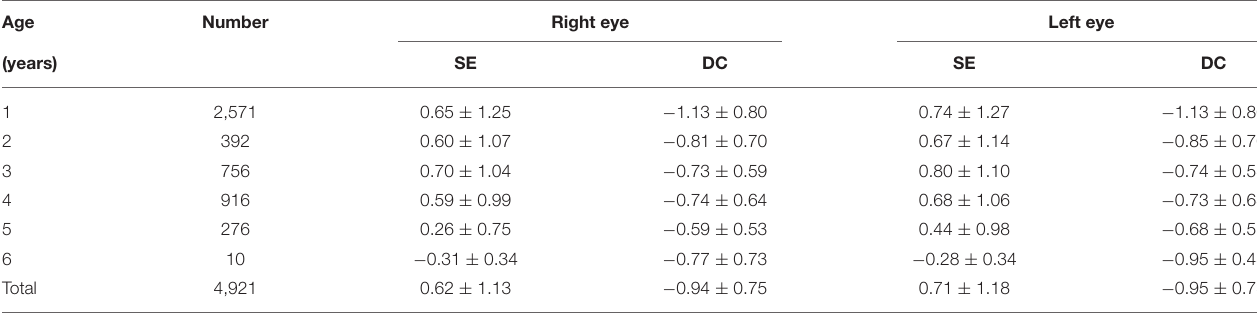
TABLE 1 | The initial refractive error of preschool children aged from 1 to